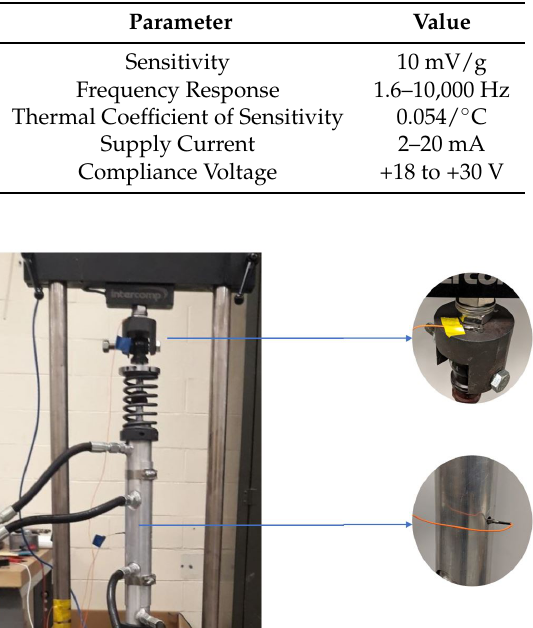
Table 3. Single Axis Accelerometer Specifications.